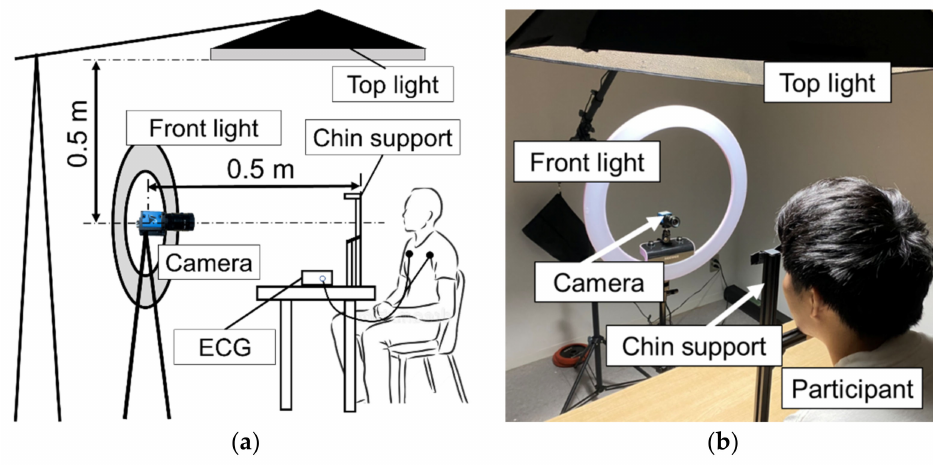
Figure 1. Experimental setup: ( a ) overview and ( b ) scene of the